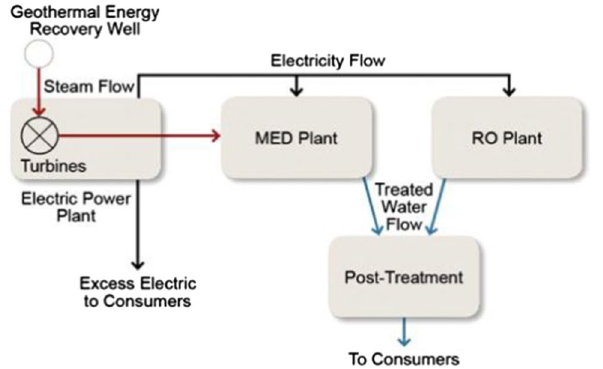
Fig. 37 The combined cycle consisted of RO, MED and geothermal plant for treating water (Gude et al. 2010)